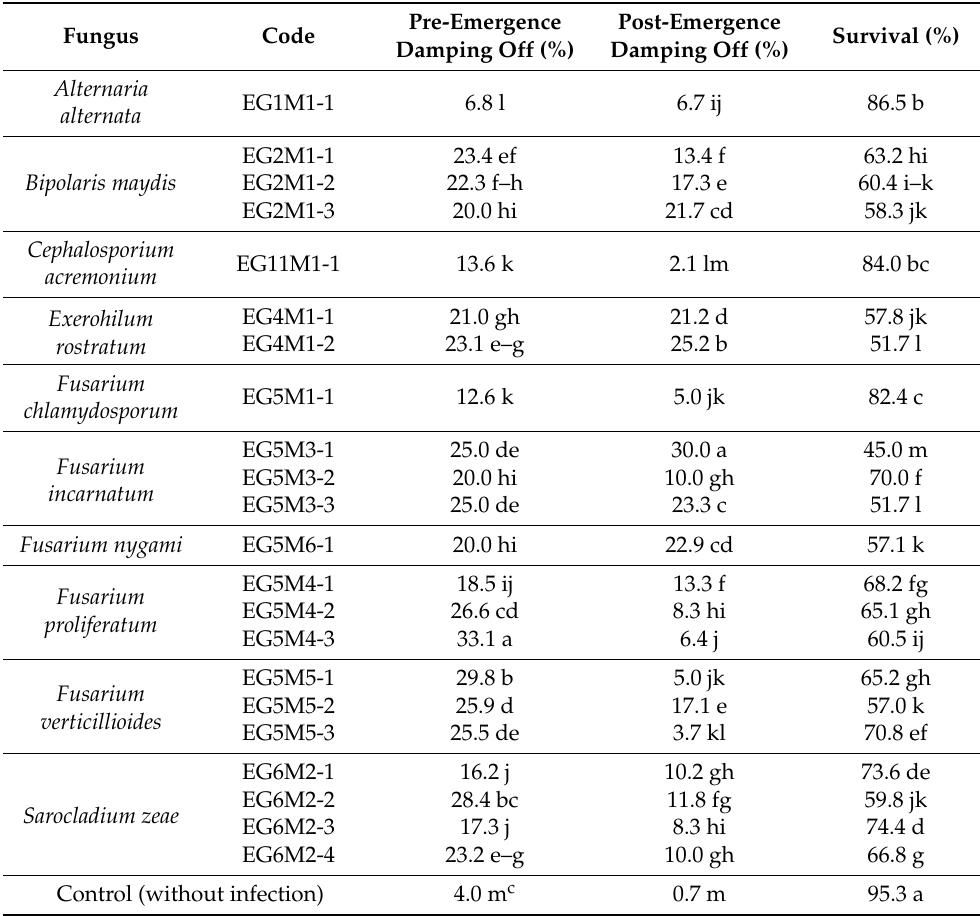
Values within a column followed by the same letter(s) are not significantly different according to Duncan’s multiple range test ( p ≤ 0.05). The disease symptoms included elongate and elliptical lesions on leaves, which later merged or coalesced and blighted the entire leaf. Infected seedlings wilted and died within 3–4 weeks. Yellowing and stunting due to infection were also observed. Among four Sorocladium zeae strains tested, isolate EG10M2-2 showed the greatest percentages of rotted seeds (28.4%) and seedling mortality (11.8%). Affected plants showed wilting of uppermost leaves and a browning vascular system in the lower portion of stems. Irregulated vascular strands due to pathogen invasion were noticed, which was accompanied by weakness of the stalk. Symptoms continued to affect the leaves showing chlorosis, necrosis, and yel- lowing which afterward turned into black. The growing-on test showed similar symptoms in all Fusarium species treatments; rotted grains, stunted and yellow seedlings. Infection with F. proliferatum (isolate EG5M4-3), followed by F. verticillioides (isolate EG5M5-1), S.